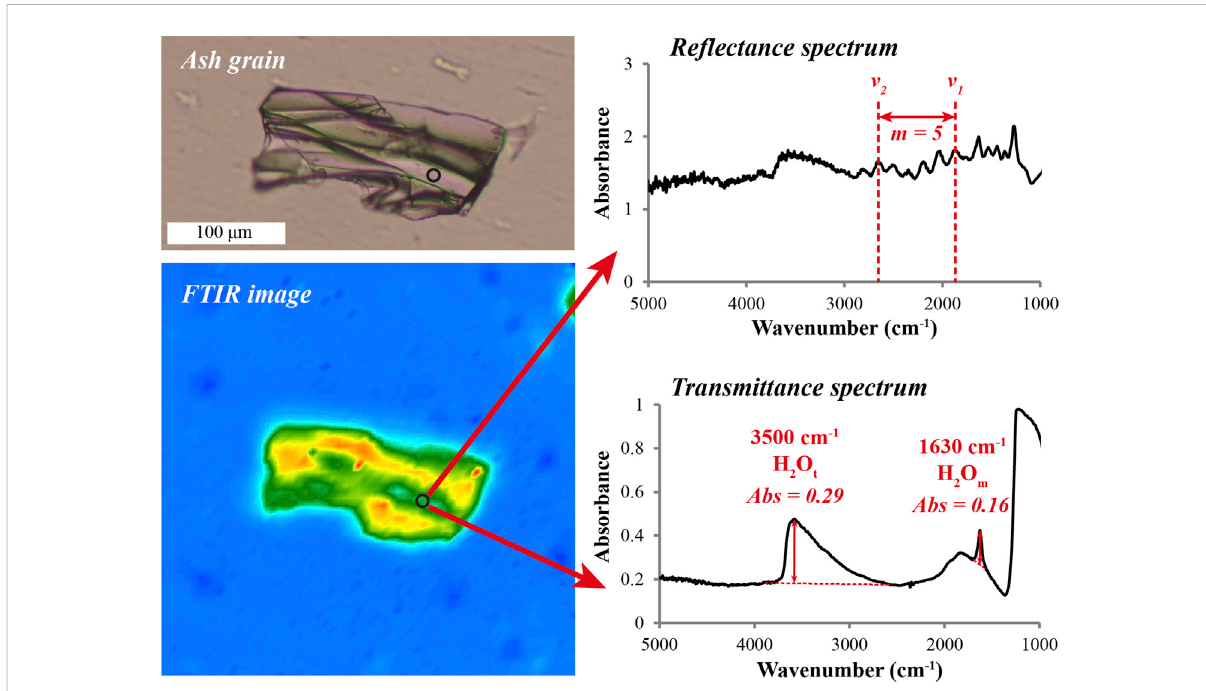
FIGURE 3 Example of imaging FTIR analysis of tephra. Transmitted light photograph of unpolished pumiceous ash grain. Tephra grains are then analyzed by imaging FTIR in both re fl ectance and transmittance modes. FTIR images are 350 x 350 μ m, comprising 64 x 64 individual spectra with spatial resolution ~5.5 x 5.5 µm. The same pixel (spectrum location) is selected from both images for processing. The re fl ectance spectrum is used to fi nd glass thickness from the distance between interference fringes (whose wavelength varies according to glass thickness and refractive index) via the method of Nichols and Wysoczanski (2007). The transmittance spectrum is used to fi nd H 2 O m and H 2 O t absorbance by measuring peak height above a baseline. Despite unpolished surfaces, Od-1 tephra spectra are well fi t by linear